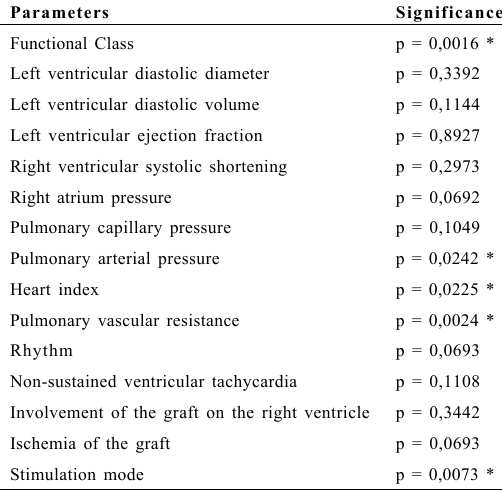
Table 2. Individual analysis of the pre-, intra- and post-operative parameters related to the survival over 9 years of follow up after dynamic cardiomyoplasty. P-values < 0.05 (asterisk) were considered significant.